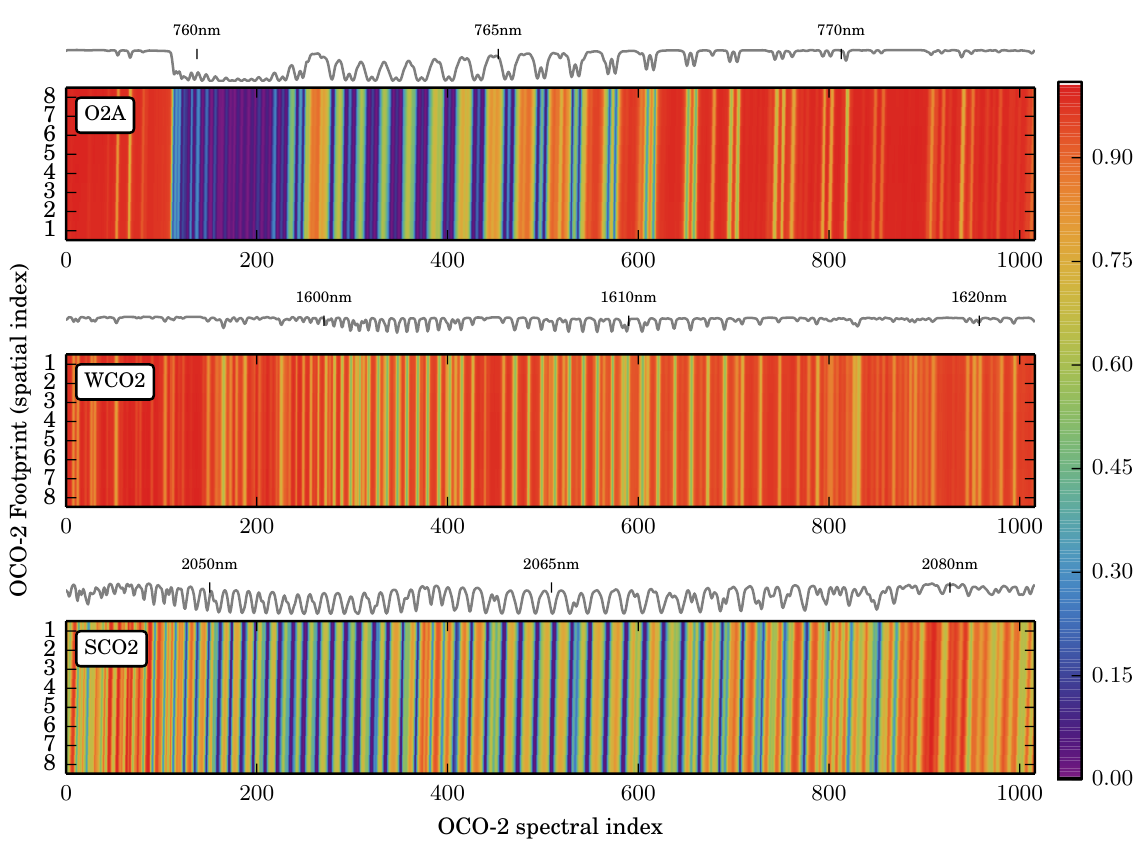
Figure 1. OCO-2 transmission spectra from TVAC direct-sun measurements at an air mass factor (AMF) of ≈ 2.5. Transmission levels from 0 to 1 are color-coded for the O2A, WCO2 and SCO2 bands, from top to bottom. The x axis represents the spectral dimension (1016 elements) of the OCO-2 focal plane and the y axis the spatial (160 elements co-added to eight individual footprints). As a guide for the eye, a spectral cross section of the center footprint is shown on top of each image, including wavelength indicators at the top. The detectors are slightly tilted with respect to the slit orientation for the O 2 A-band in particular, but also for the strong CO 2 band, causing a stronger footprint dependence of the dispersion coefficients.